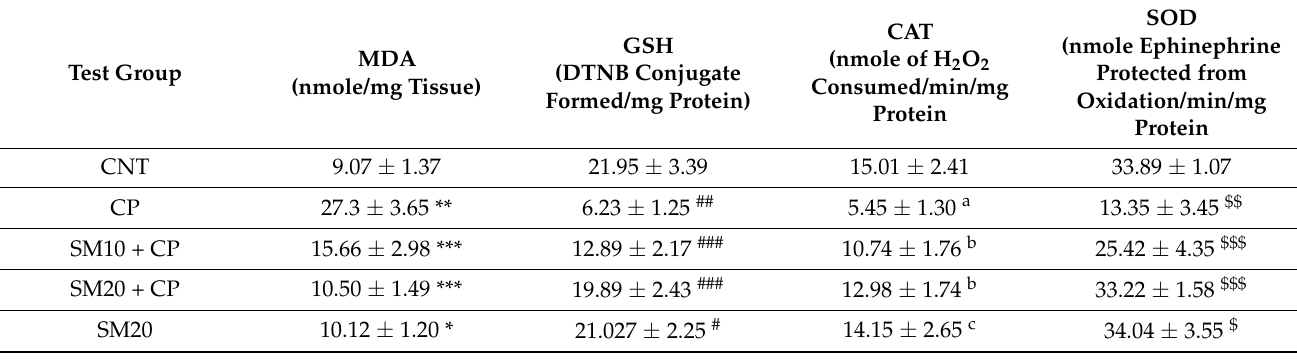
Table 2. Effects of SM on oxidative stress against CP-induced renal toxicity.